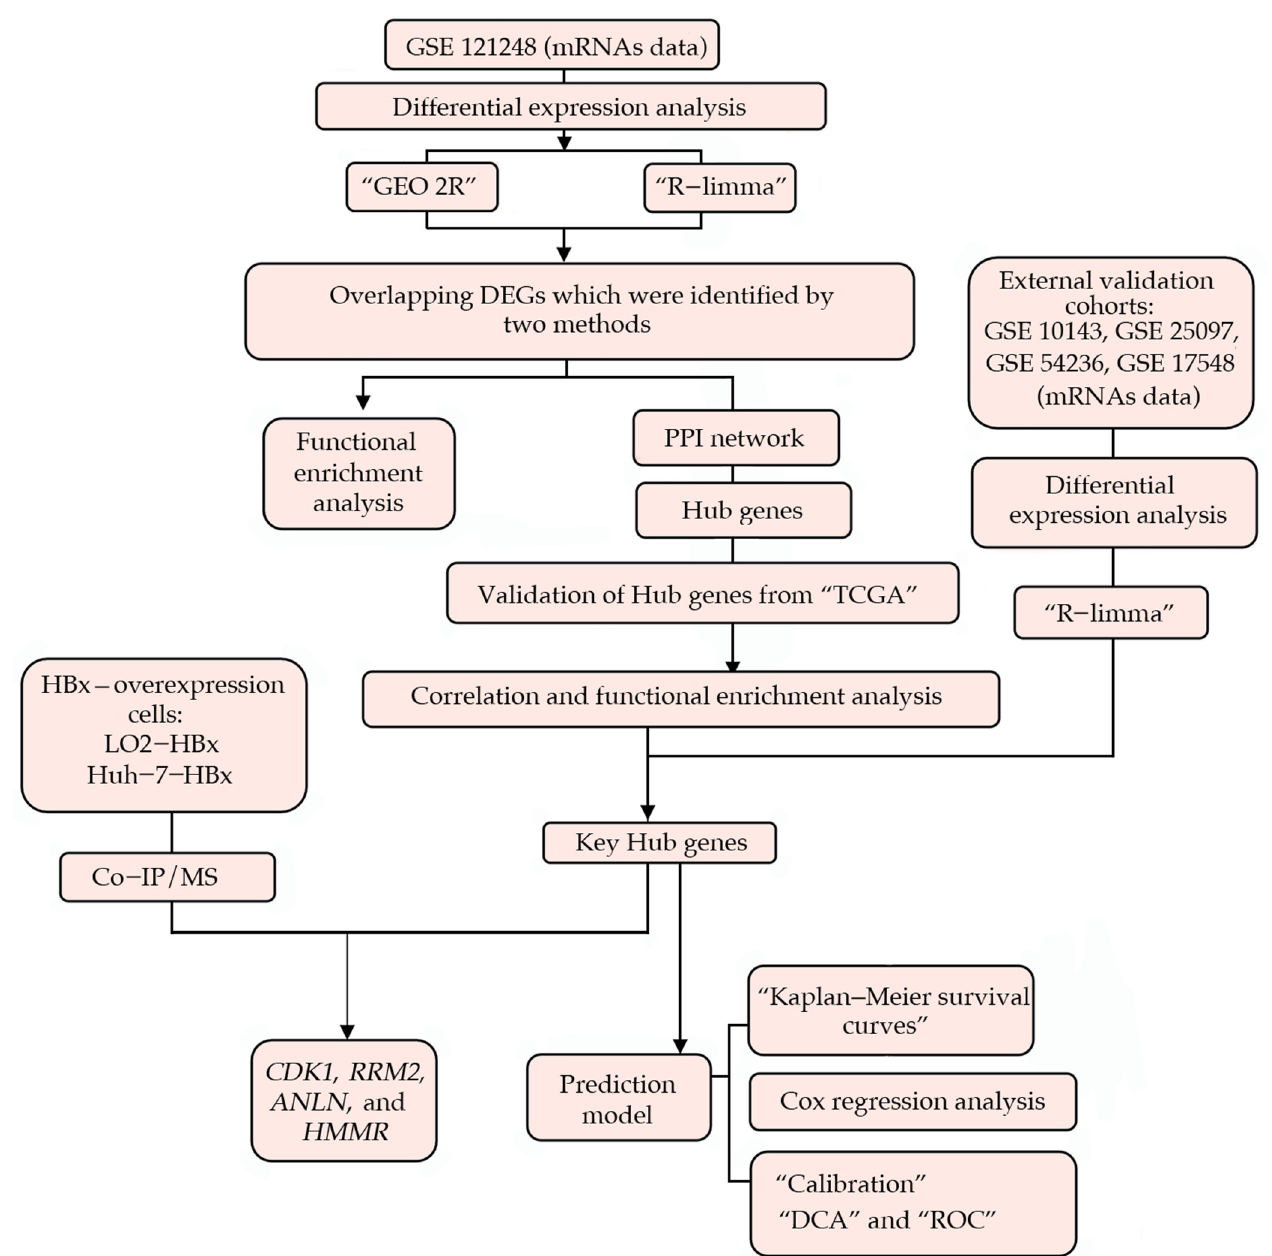
Figure 1. The workflow diagram of data acquisition, preprocessing, analysis, and validation. Two distinct techniques were used to identify DEGs in the GSE121248 dataset. Among the DEGs, a PPI network was constructed, and Cytoscape was used to extract hub genes. The TCGA database validated the expression levels, correlation analysis, and predictive performance of hub genes. Using the GSE10143, GSE25097, GSE54236, and GSE17548 datasets, the expression pattern of hub genes during the progression from cirrhosis to HCC was analyzed. A prediction model was then developed using Cox regression analysis. In both cell models, CDK1, RRM2, ANLN, and HMMR interacted specifically with HBx, as determined by Co − IP/MS. DEGs, differentially expressed genes; Co − IP/MS, co − immunoprecipitation coupled with mass spectrometry; PPI, protein–protein interaction.